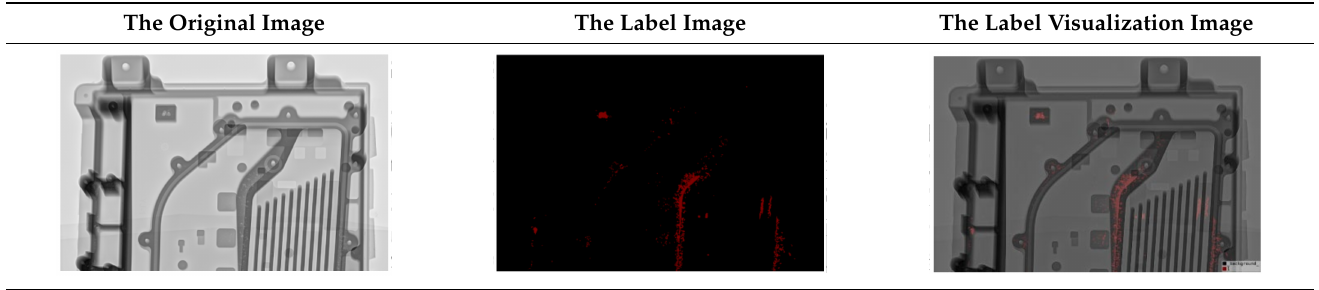
Table 4. The architecture of one annotation result, basic configuration of the core imaging chain components from the X-ray inspection equipment of Figure